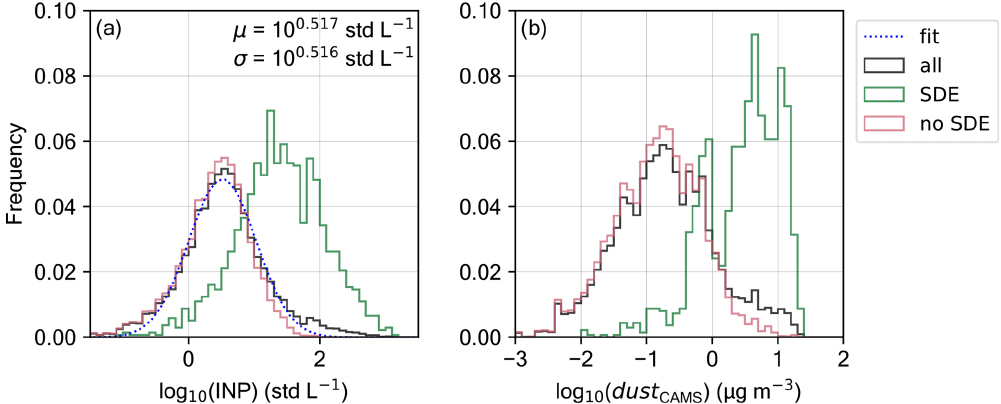
Figure 6. Frequency distributions of INP concentrations ( a ) and dust CAMS ( b ) between 7 February and 31 December 2020 (solid black) for all classified SDEs (lcSDE and hcSDE, green) and for periods without SDEs (pink). A lognormal curve with stated curve parameter in ( a ) has been fitted to the frequency distribution of all INP concentrations (dashed blue). The area under each frequency distribution is normalized to unity, which does not allow for the sum of the areas below the SDE and non-SDE frequency distributions to be equal to the area below the frequency distribution of all classified